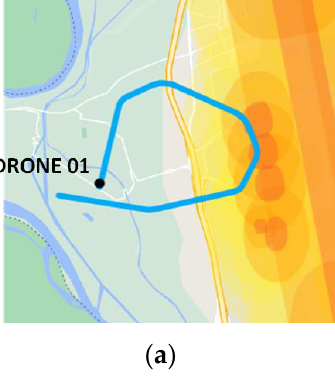
Figure 16. Instances of threat scenario class “Threat parallel to RWYs”.